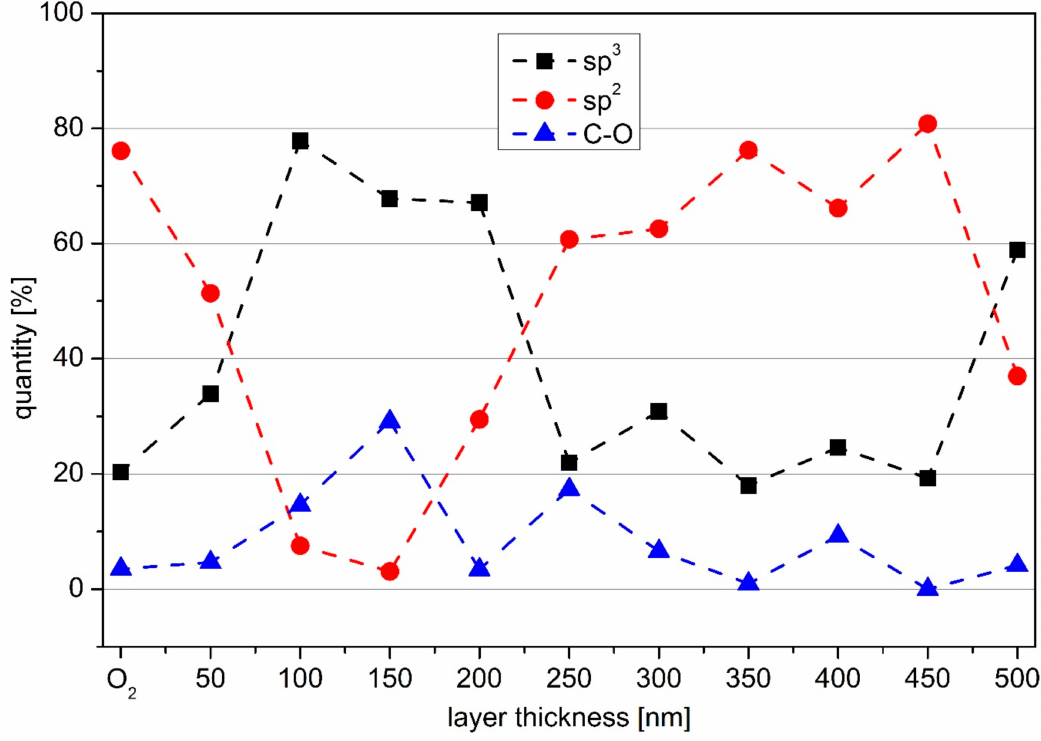
Figure 4. Results for the deconvoluted X-ray photoelectron spectroscopy (XPS) spectra for PBAT. The percentages for the amount of sp 3 (squares), sp 2 (circles), and C–O bond (triangles) for coatings with increasing a-C:H layer thickness are shown (dashed lines are only included for